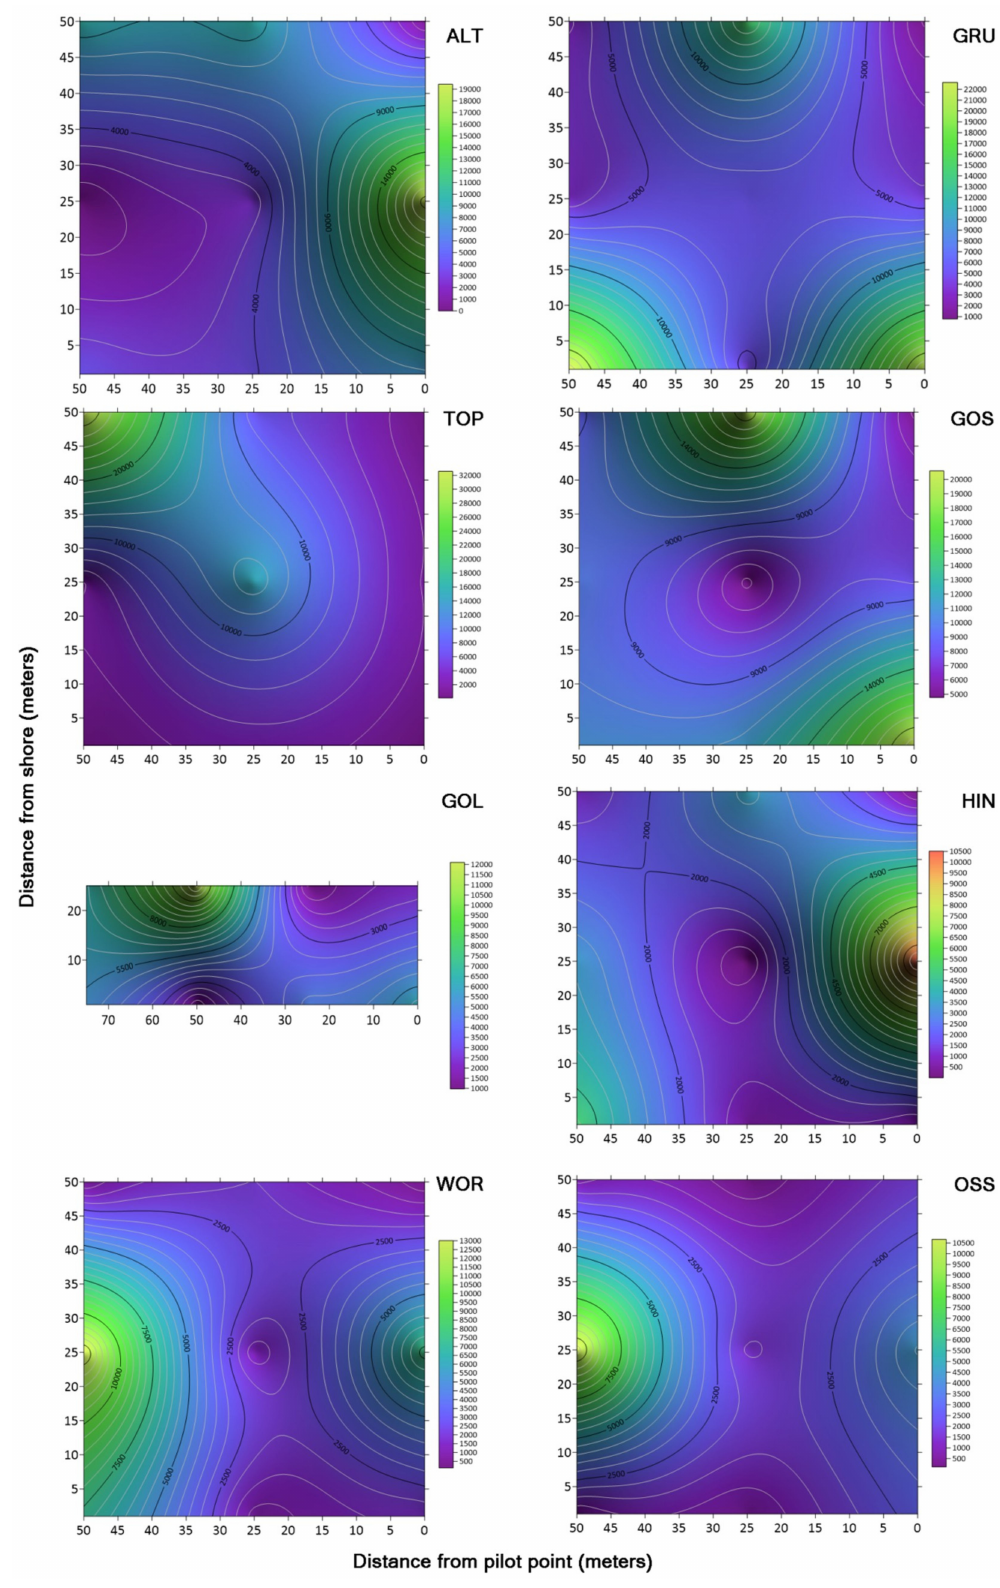
Figure 6. Contour maps of the spatial distribution of bacteria (meters) cultured from each of the Austrian lakes on KBC agar media (CFU/mL). These contour maps were created using the Surfer 15 software using the concentration data for each sample site in each lake. The small area mini-lake, Gosaulacke (GOL), had an alternate sample collection grid. Sample collections were plotted on a Cartesian